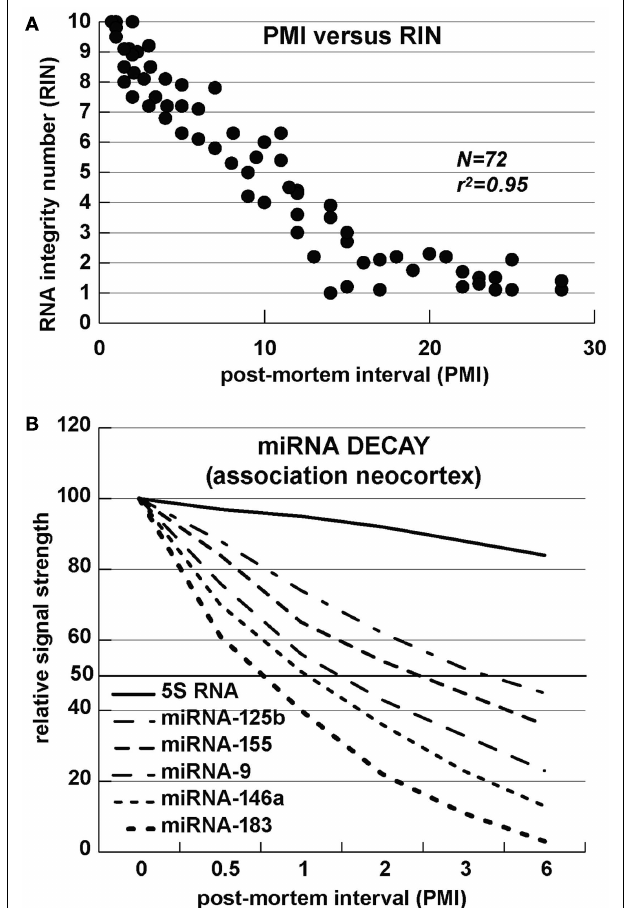
FIGURE 2 | miRNA stability – (A) RNA integrity number (RIN) versus post-mortem interval (PMI); the correlation of RNA integrity to a positive RIN number is statistically highly significant ( r 2 ∼ 0.95; N = 72); (B) Half-life of several selected miRNAs; the content, position and 5 (cid:48) –3 (cid:48) orientation ofA and U ribonucleotides, andAU-rich elements (AREs) appears to affect miRNA stability, with half-lives generally in the range of 1–7h (see Sethi and Lukiw, 2009; Rüegger and Großhans, 2012; Zhang et al.,